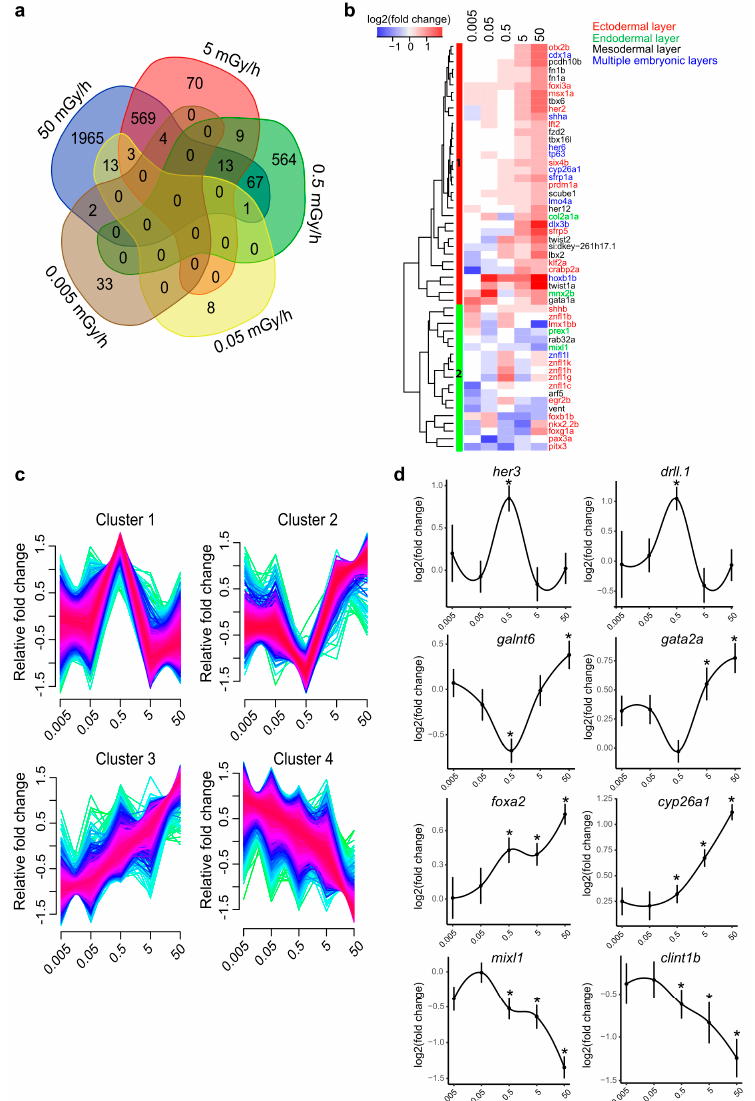
Figure 1. Transcriptomic analysis of shield embryos (6 hpf) exposed to ionising radiation (IR). Dose rates are indicated in mGy / h. ( a ) Venn diagram of di ff erentially expressed genes at the five dose rates ( | fold change | ≥ 1.5 and adjusted p -value < 0.01). ( b ) Hierarchical clustering of log2 fold change across all dose rates of genes known to be expressed in the di ff erent germ layers during gastrulation (based on ZFIN annotations, see Material and Methods). Known expression in the ectoderm (red), endoderm (green), mesoderm (black) or in multiple embryonic layers (blue) is indicated. Upregulated genes are displayed in red, downregulated genes in blue and no changes in white. Cluster 1 (red) and cluster 2 (green) are indicated. ( c ) Expression patterns obtained by fuzz-mean clustering of 3319 selected DEG misregulated in at least one condition ( | fold change | ≥ 1.5 and adjusted p -value < 0.01). The fold- change were normalised on the same scale, and the y-axes indicate relative fold change. Genes with high cluster membership are displayed as red lines, those with moderate membership in blue and low membership in green. ( d ) Example of gene expression patterns across the di ff erent dose rates using loess-smoothed conditional means. Two genes are displayed for each of the four clusters detected by fuzzy-mean clustering. Mean of log2 (fold change) are indicated as dots and standard errors are indicated as vertical bars (* adjusted p -value <